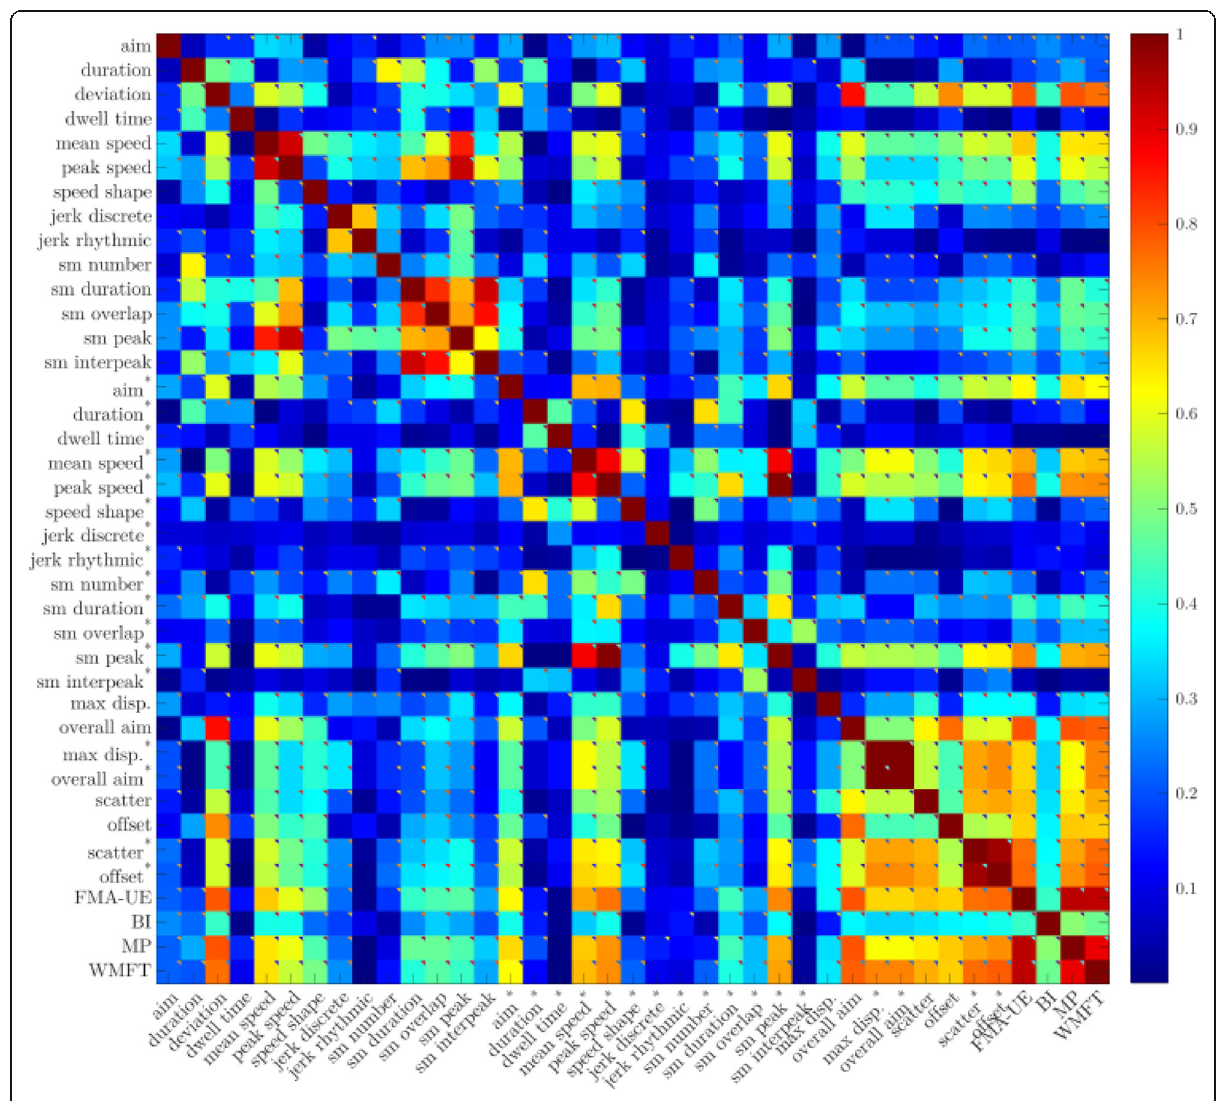
Fig. 2 Heatmap of wrist-forearm kinematic data correlation with clinical